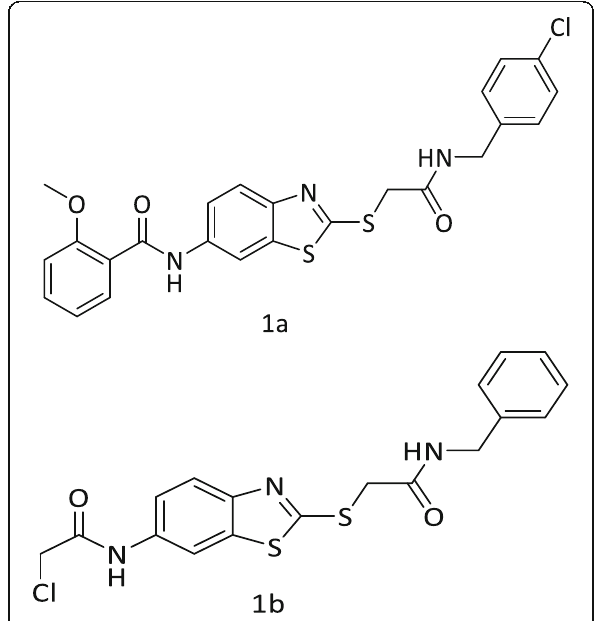
Fig. 21 Benzoxazole-5-carbohydrazide derivatives Fig. 23 Benzothiazole-amide derivatives